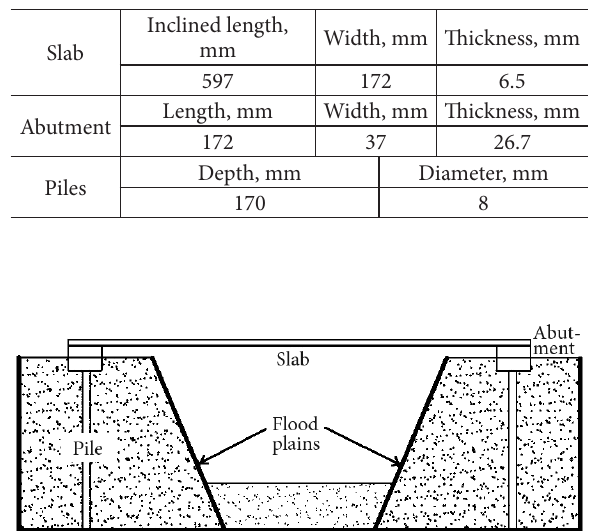
Fig. 1. Skewed integral bridge setup in the flood plains